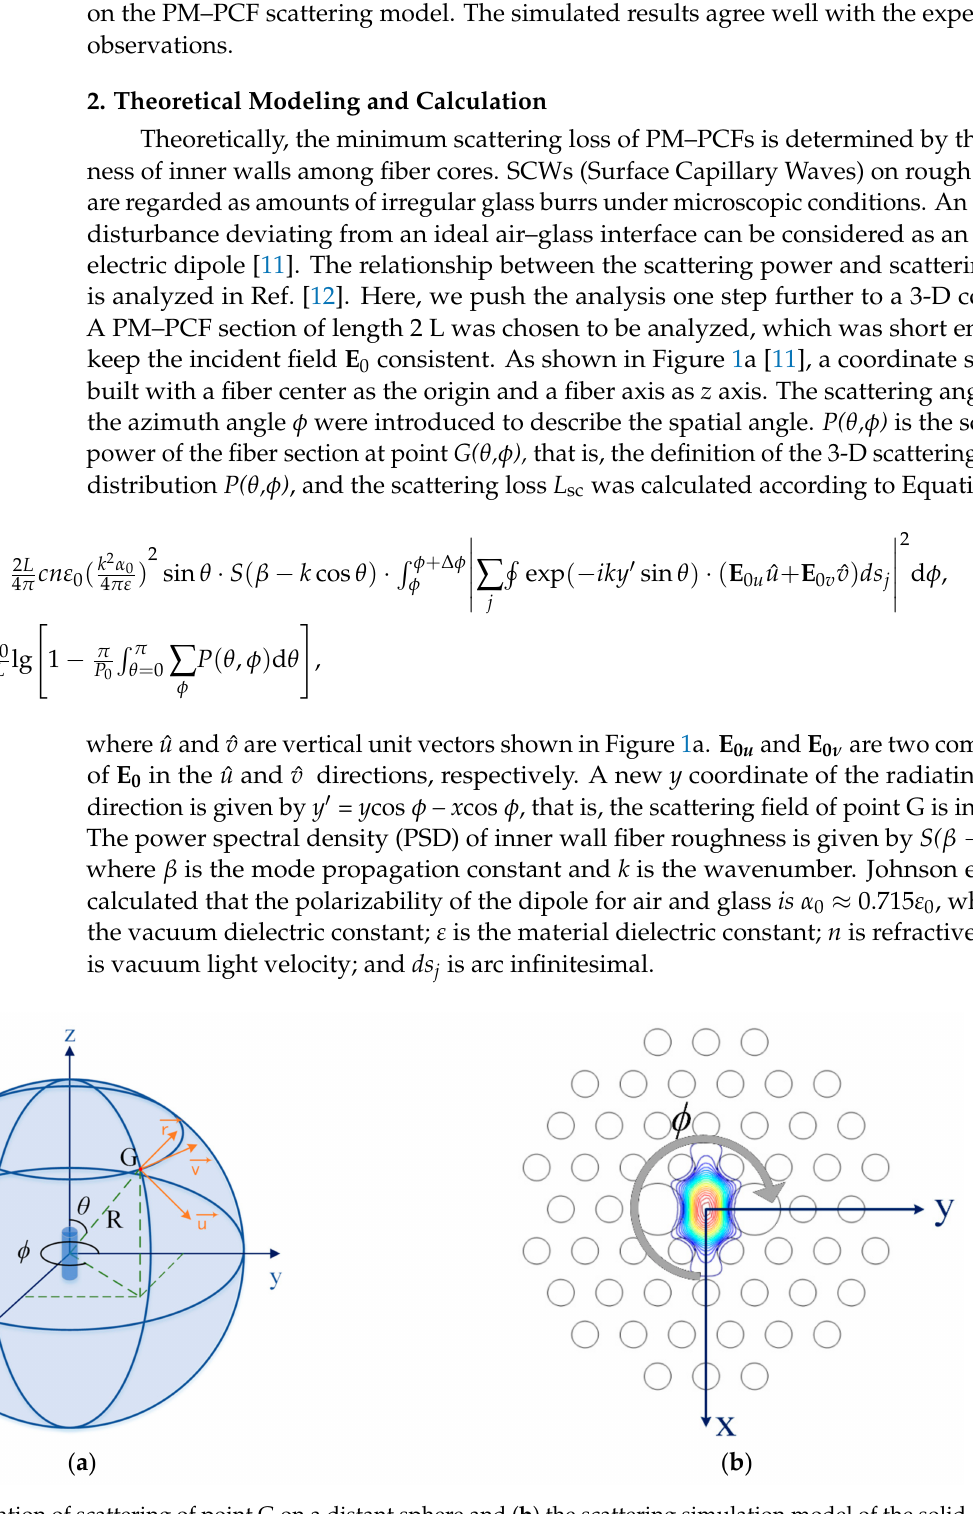
Figure 1. ( a ) Illustration of scattering of point G on a distant sphere and ( b ) the scattering simulation model of the solid-core